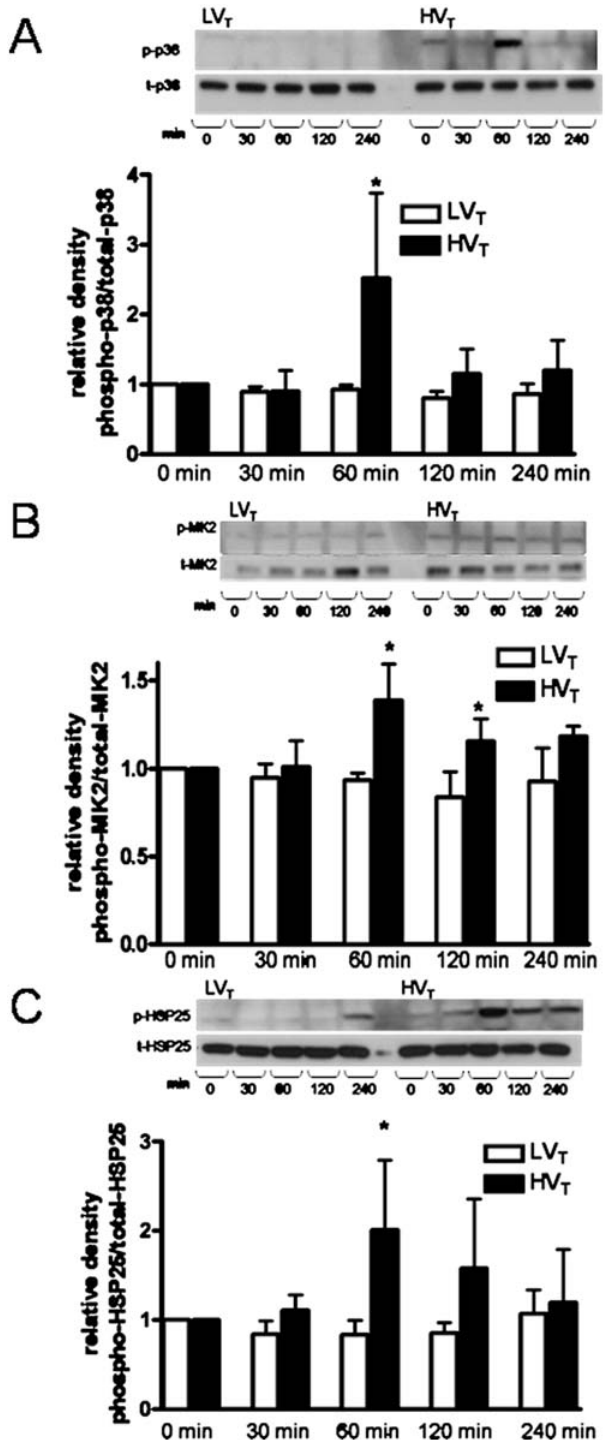
Figure 2. High tidal volume mechanical ventilation activates the p38 MAP kinase-MK2-HSP25 signaling cascade. C57BL/6J mice were randomized to MV at LV T (7 ml/kg) and HV T (20 ml/kg) for 0, 30, 60, 120 and 240 minutes after which lungs were harvested for protein analysis. Lung tissue homogenates were immunoblotted for phosphorylated and total isoforms of p38 MAP kinase, MK2 and HSP25. A. A representative Western blot indicates an increase in the phosphorylated isoform of p38 MAP kinase with MV at high tidal volumes as compared to low tidal volumes. Densitometric